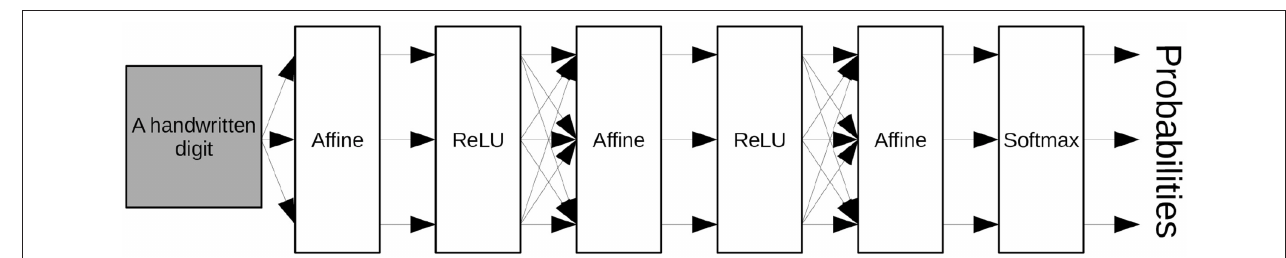
FIGURE 3 | Neural network diagram used to recognizing the MNIST handwritten digits.